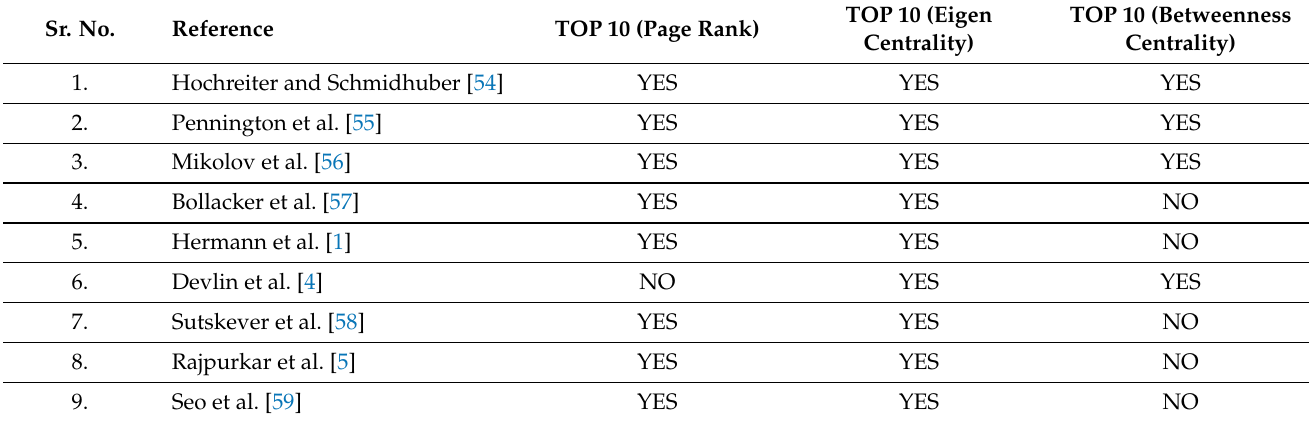
Table 9. Co-Citation